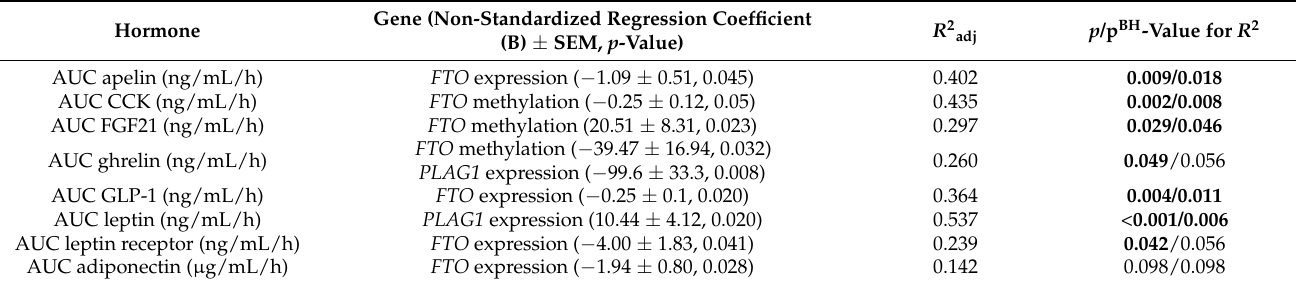
Table 6. Multiple linear regression analysis of the FTO gene methylation, FTO gene expression and PLAG1 expression as predictors of changes in the plasma concentrations of adipokines and gastrointestinal tract hormones in children. Only the non-standardized regression coefficients1 with p < 0.05 are shown.